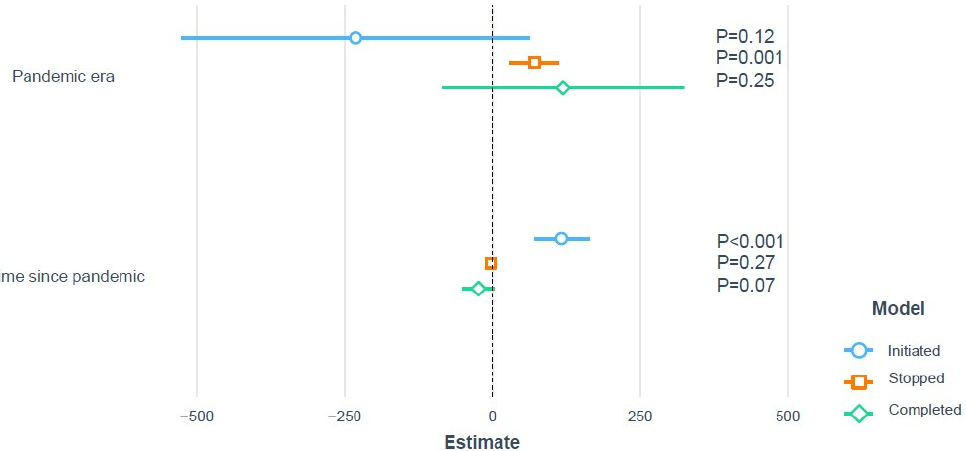
Figure 2. Piecewise linear regression of monthly trend of initiated, stopped and completed trials during the pandemic era and time since pandemic based on monthly number and percentages, respectively.